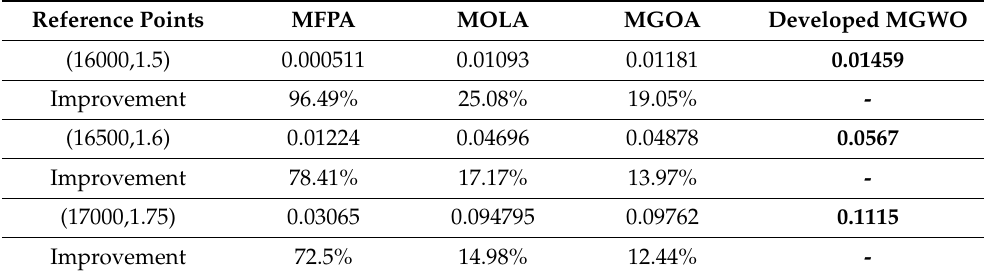
Table 7. Hypervolume indicators of MGWO, MFPA, MOLA, and MGOA for TLSM design under third case.